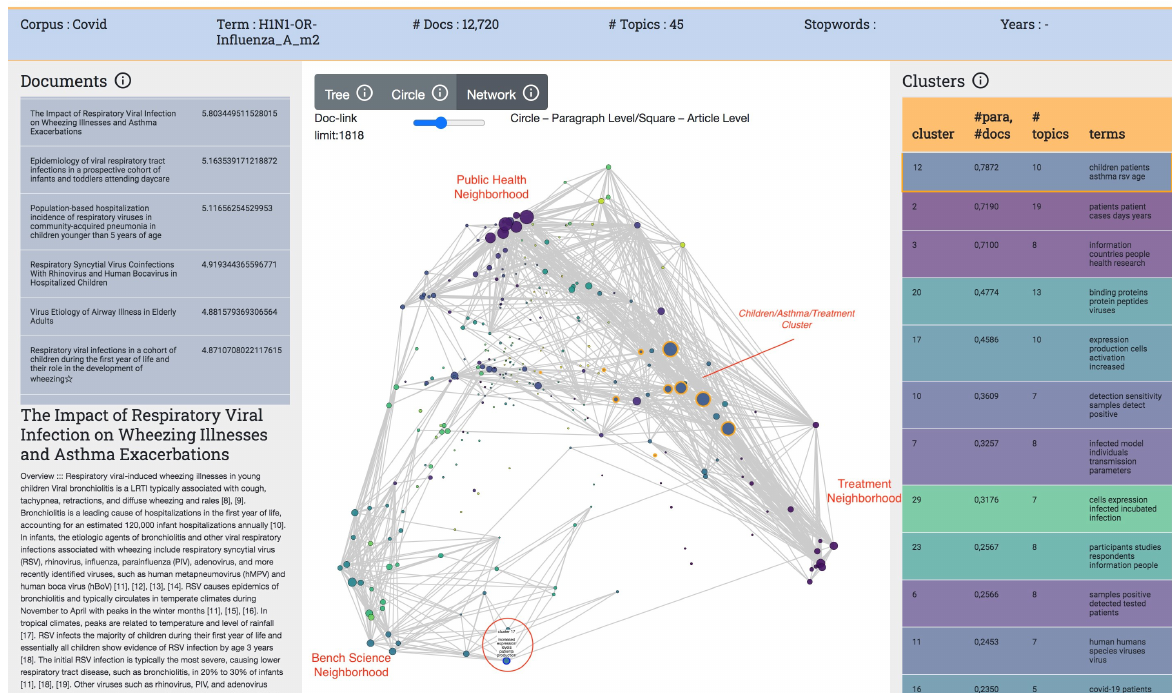
Figure 10. Network visualization of the H1N1 Topic Model.